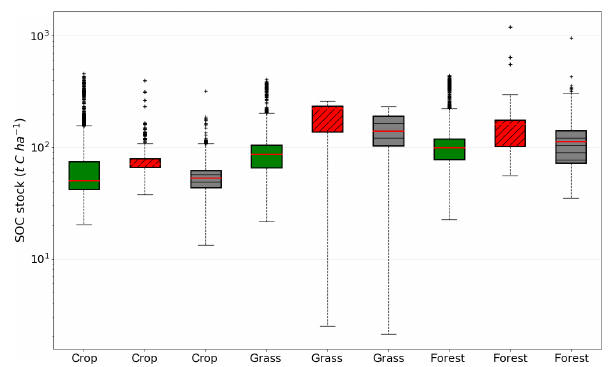
Figure 6. Comparison of the total SOC stocks per land cover type between the simulation without erosion (red boxes with a “//” pat- tern), the simulation with erosion (black boxes with a “–” pattern), and the LUCAS data (green boxes without pattern fill). The red hor- izontal lines are the medians, the dashed vertical lines represent the range between the minimum and maximum, and the black dots are the outliers.